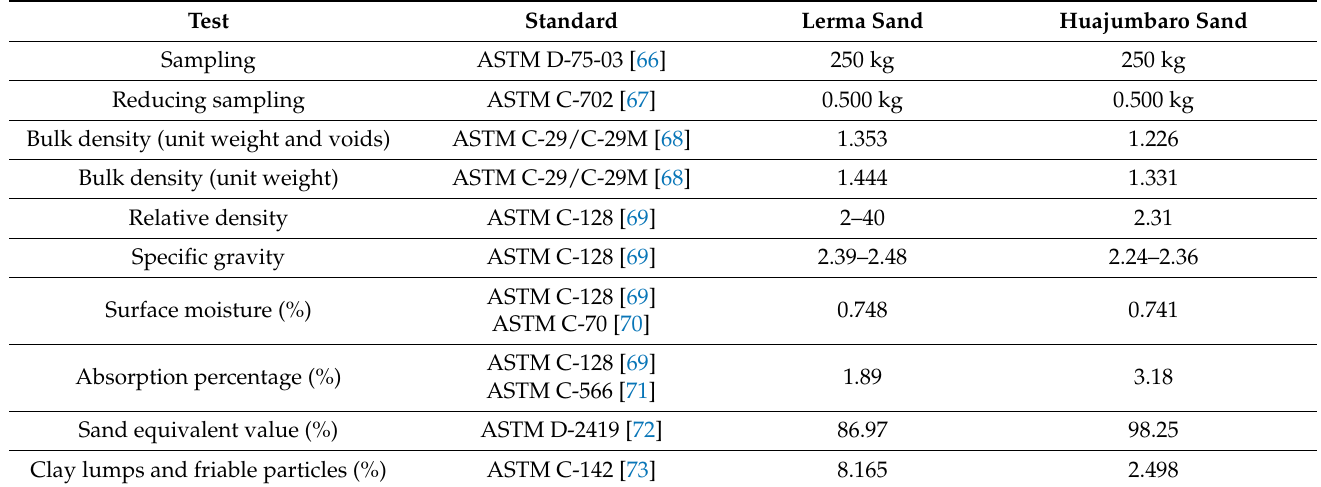
Table 2. Results of the mechanical properties of the aggregates used.